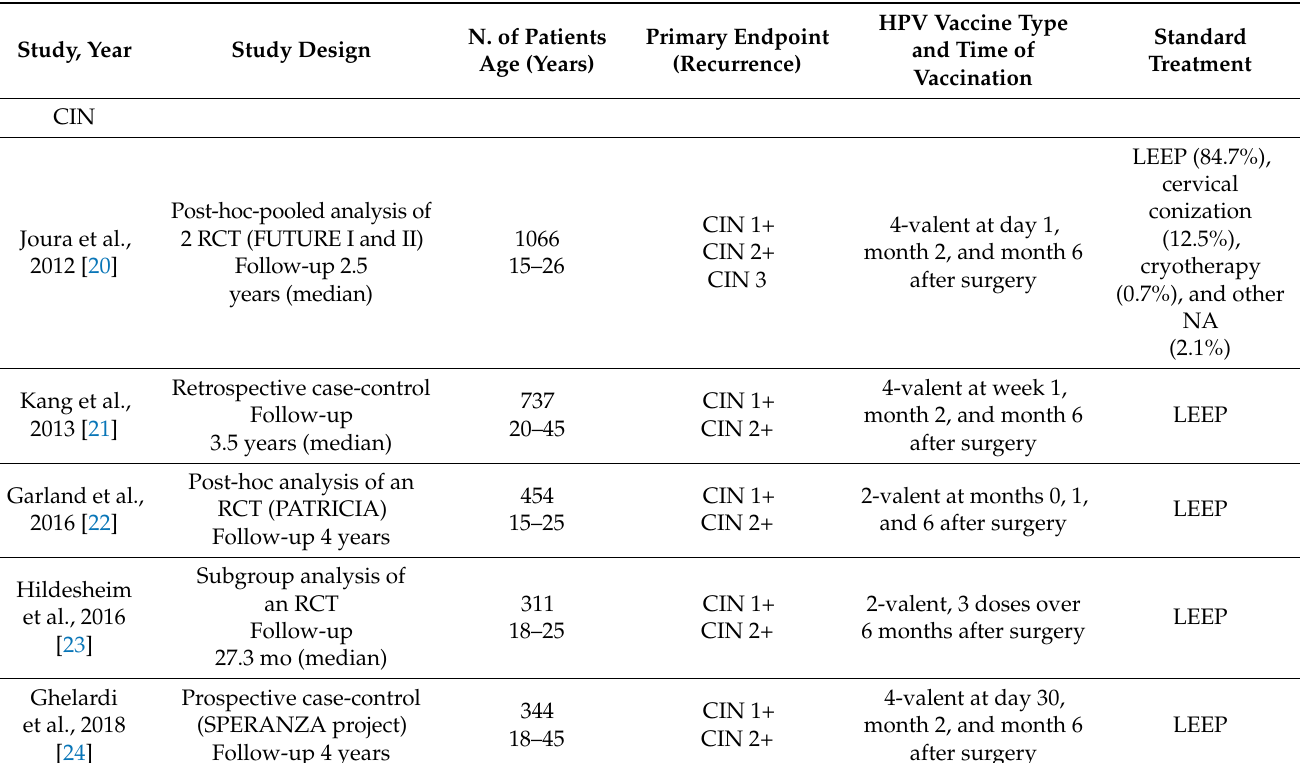
Table 1. Description of the studies